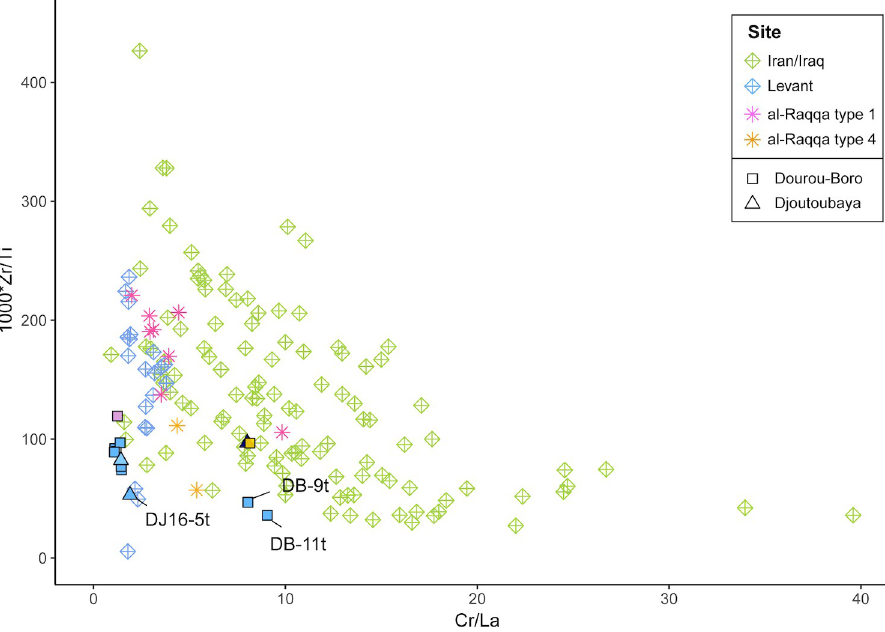
Fig 12. Trace elements composition of Dourou-Boro and Djoutoubaya glasses compared to contemporary glasses. Zirconium to titanium versus chromium to lanthanum ratios of glasses from Dourou-Boro and Djoutoubaya compared to Levantine and Mesopotamian glasses showing the different sources of raw